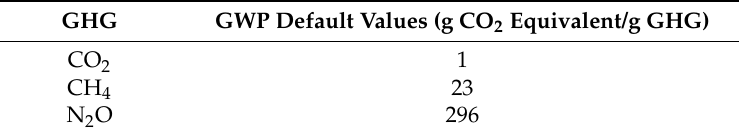
Table 2. GWP values of greenhouse gases